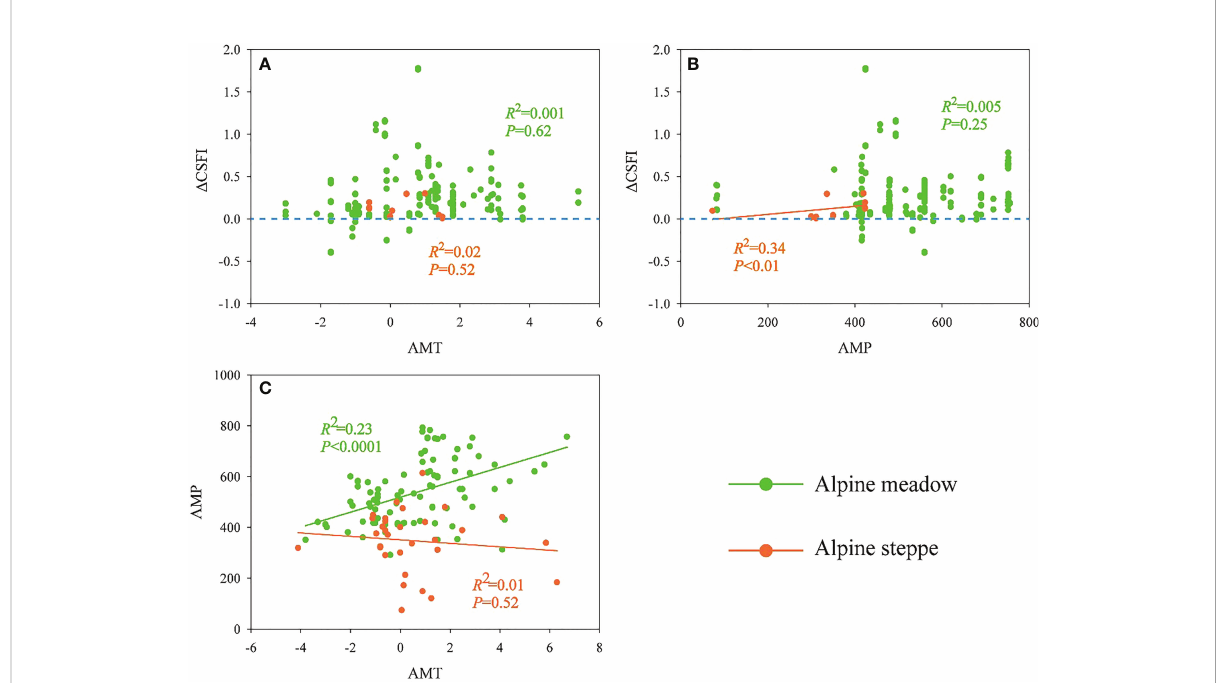
FIGURE 6 The relationships between (A) D CSFI and annual mean temperature (AMT), (B) D CSFI and annual mean precipitation (AMP) and (C) annual mean temperature (AMT) and annual mean precipitation (AMP) across alpine meadow and steppe. CSFI represents the composite index of carbon stock